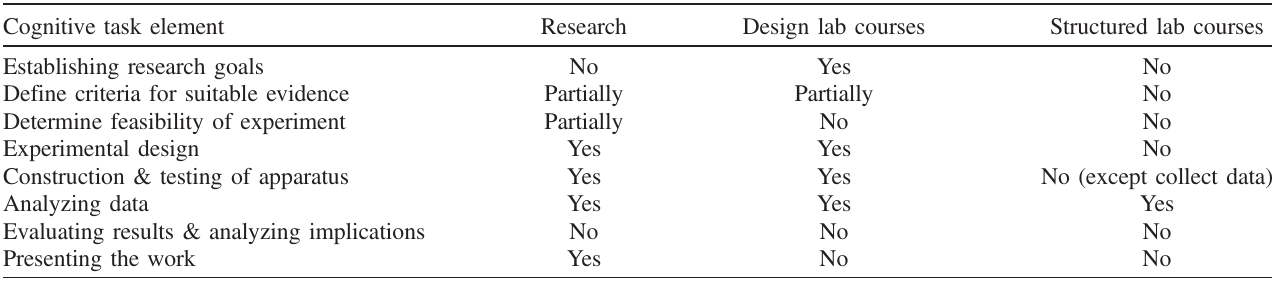
TABLE II. Broad summary of elements that are and are not included in undergraduate research, design lab courses, or structured lab